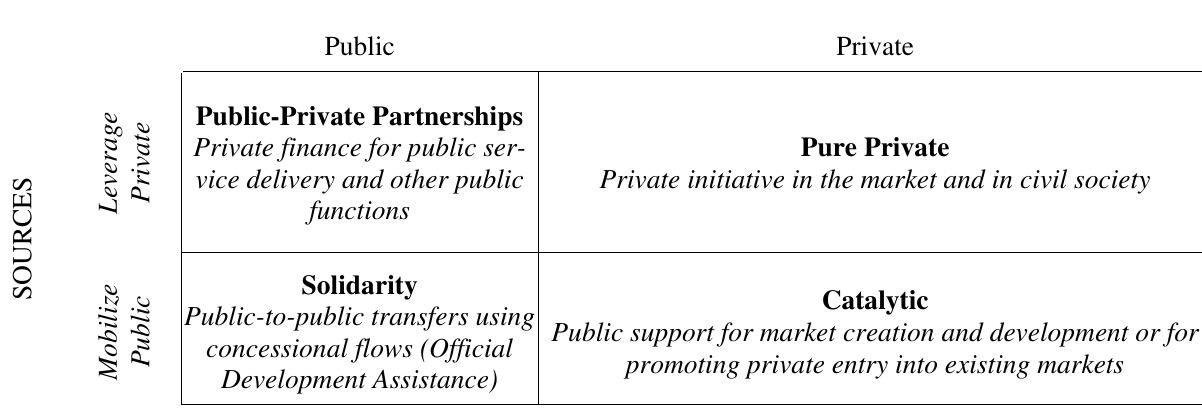
Figure 2. Innovative mechanisms of development